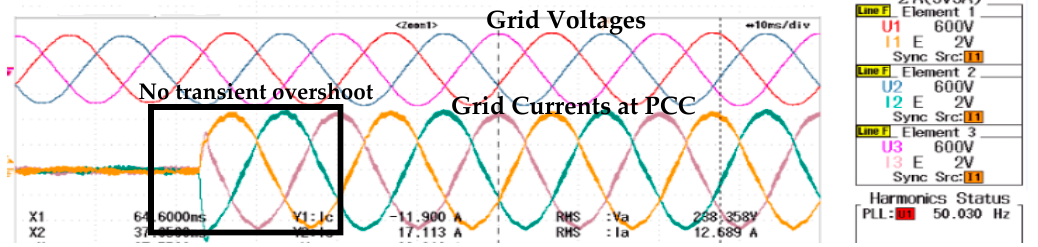
Figure 19. Grid voltages and currents when the step reference from 0 to 10 kW has been applied.